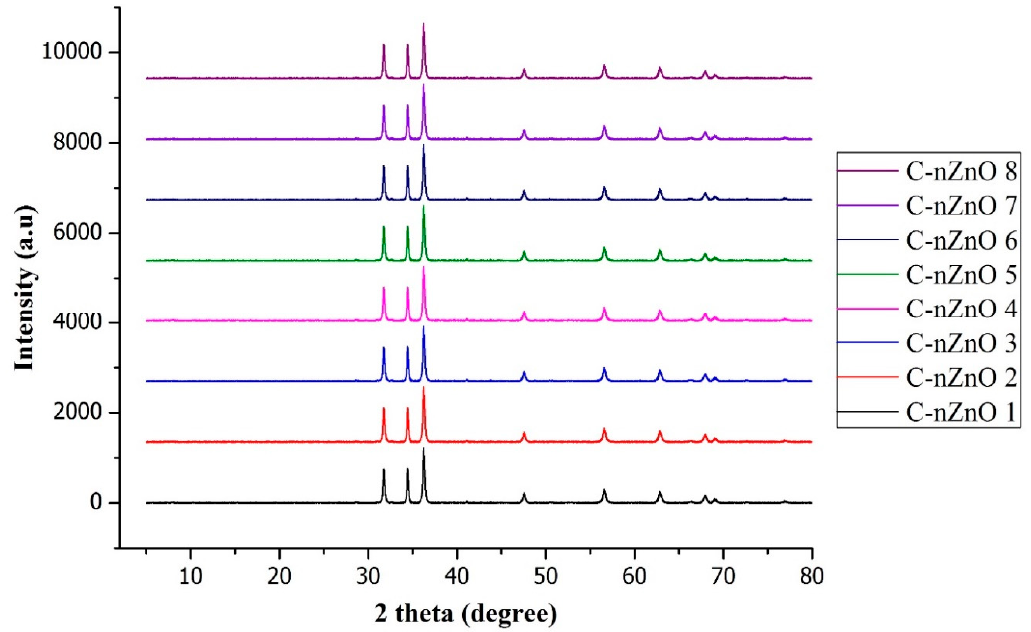
Figure 4. XRD di ff raction patterns of all treated Figure 4. XRD diffraction patterns of all treated samples.